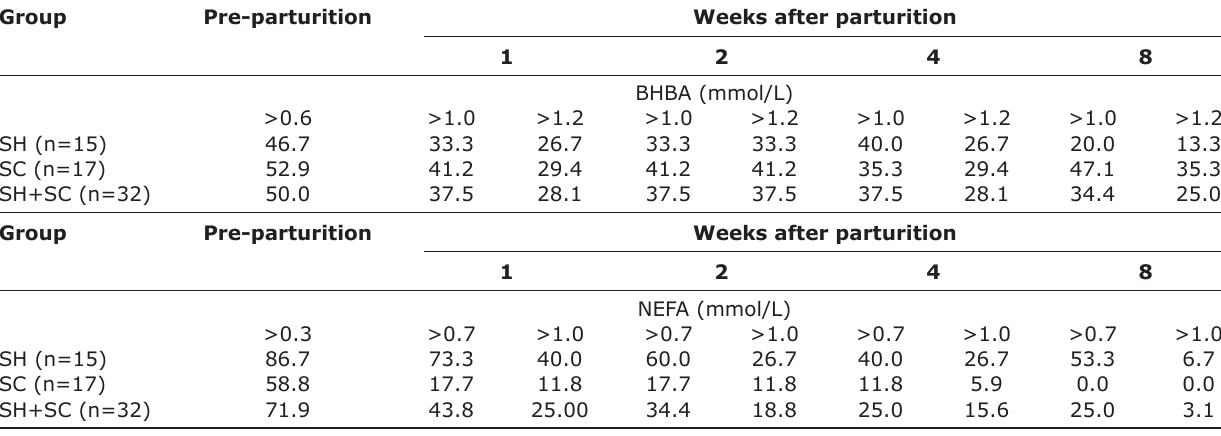
Table-2: Percentage of cows classified by serum non-esterified fatty acid (NEFA; prepartum>0.3 mmol/L; postpartum>0.7 mmol/L, >1.0 mmol/L) and β -hydroxybutyrate (BHBA; prepartum>0.6 mmol/L; postpartum>1.0 mmol/L, >1.2 mmol/L) concentrations in smallholder (SH, n=15) and semi-commercial (SC, n=17) at 2 weeks prepartum and 1, 2, 4, and 8 weeks postpartum. Group